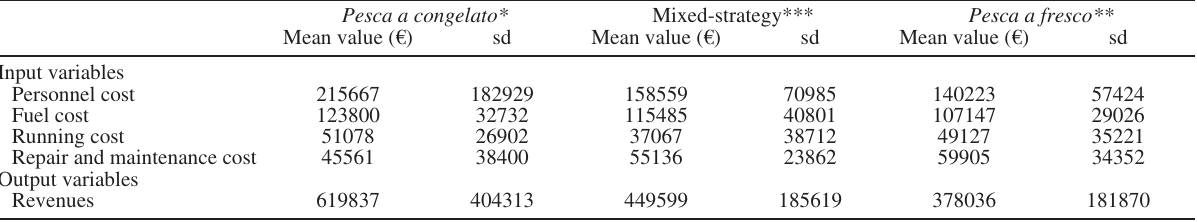
Table 3. – Descriptive statistics of the input and output variables used in the data envelopment analysis (DEA), n=56 (total population, N=85) (2016 data). The cost and revenue variables are presented for the three fishing strategies as mean values with the associated